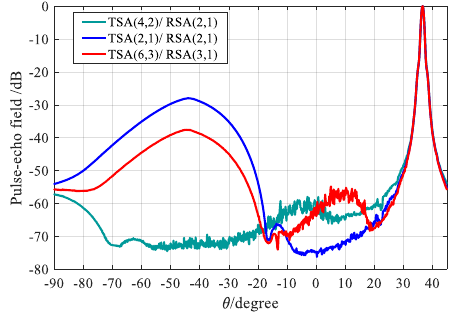
Figure 6. Comparison of beam patterns.